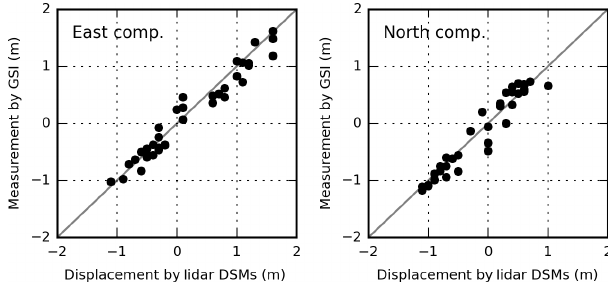
Figure 3. Comparison between the coseismic displacements esti- mated from the lidar data (Moya et al., 2017) and from field mea- surements (Geospatial Information Authority of Japan,